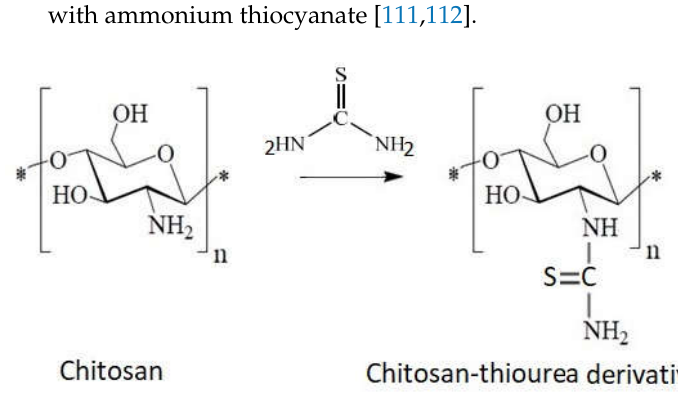
Figure 14. Schematic of chitosan sulfonation via mercaptoacetic acid. 3. Grafting of thiourea (Figure 15) via a cross-linking agent or by a chitosan reaction with ammonium thiocyanate [111,112].